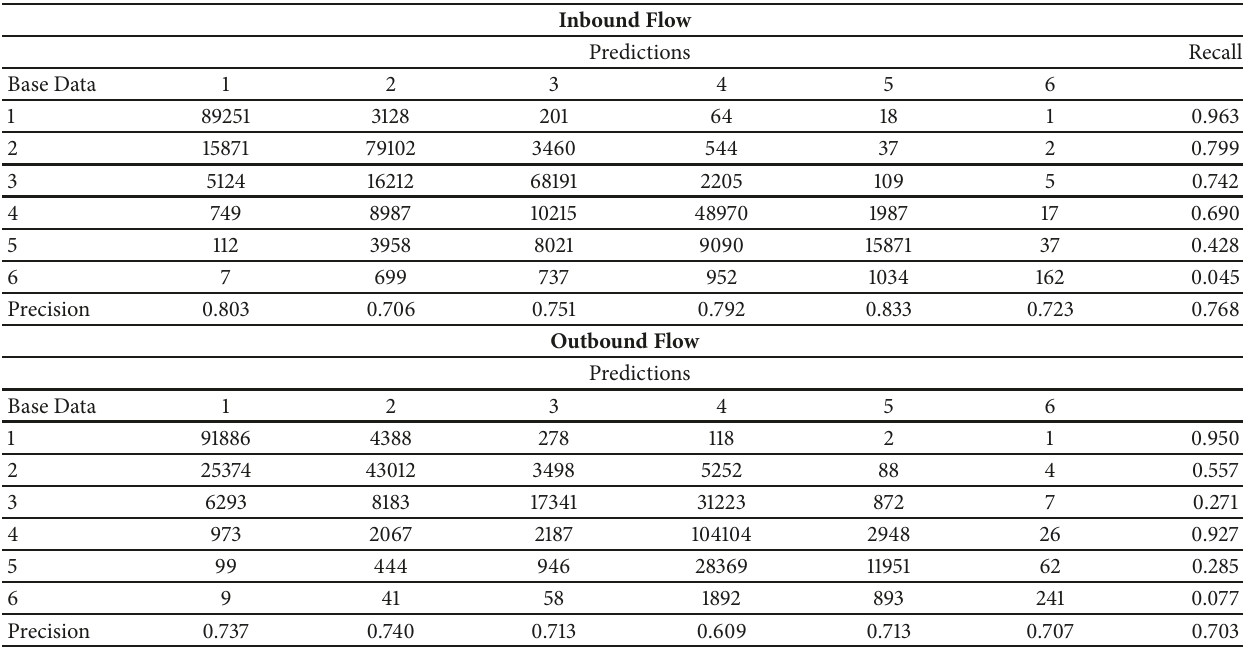
Table 2: Predicted inbound/outbound flow